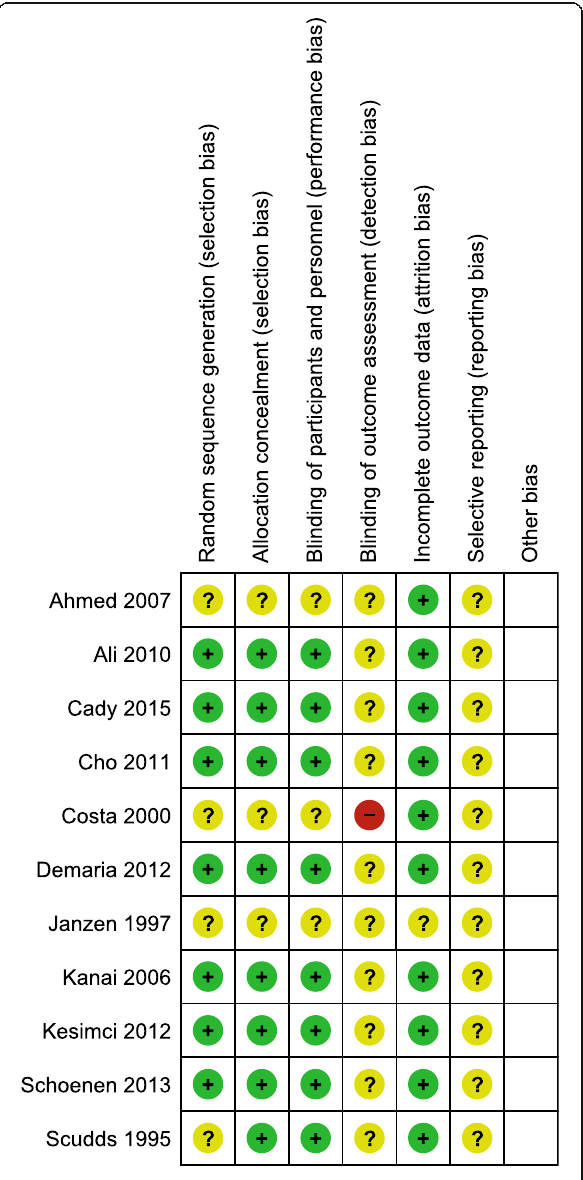
Fig. 2 Risk of bias summary of randomized-controlled